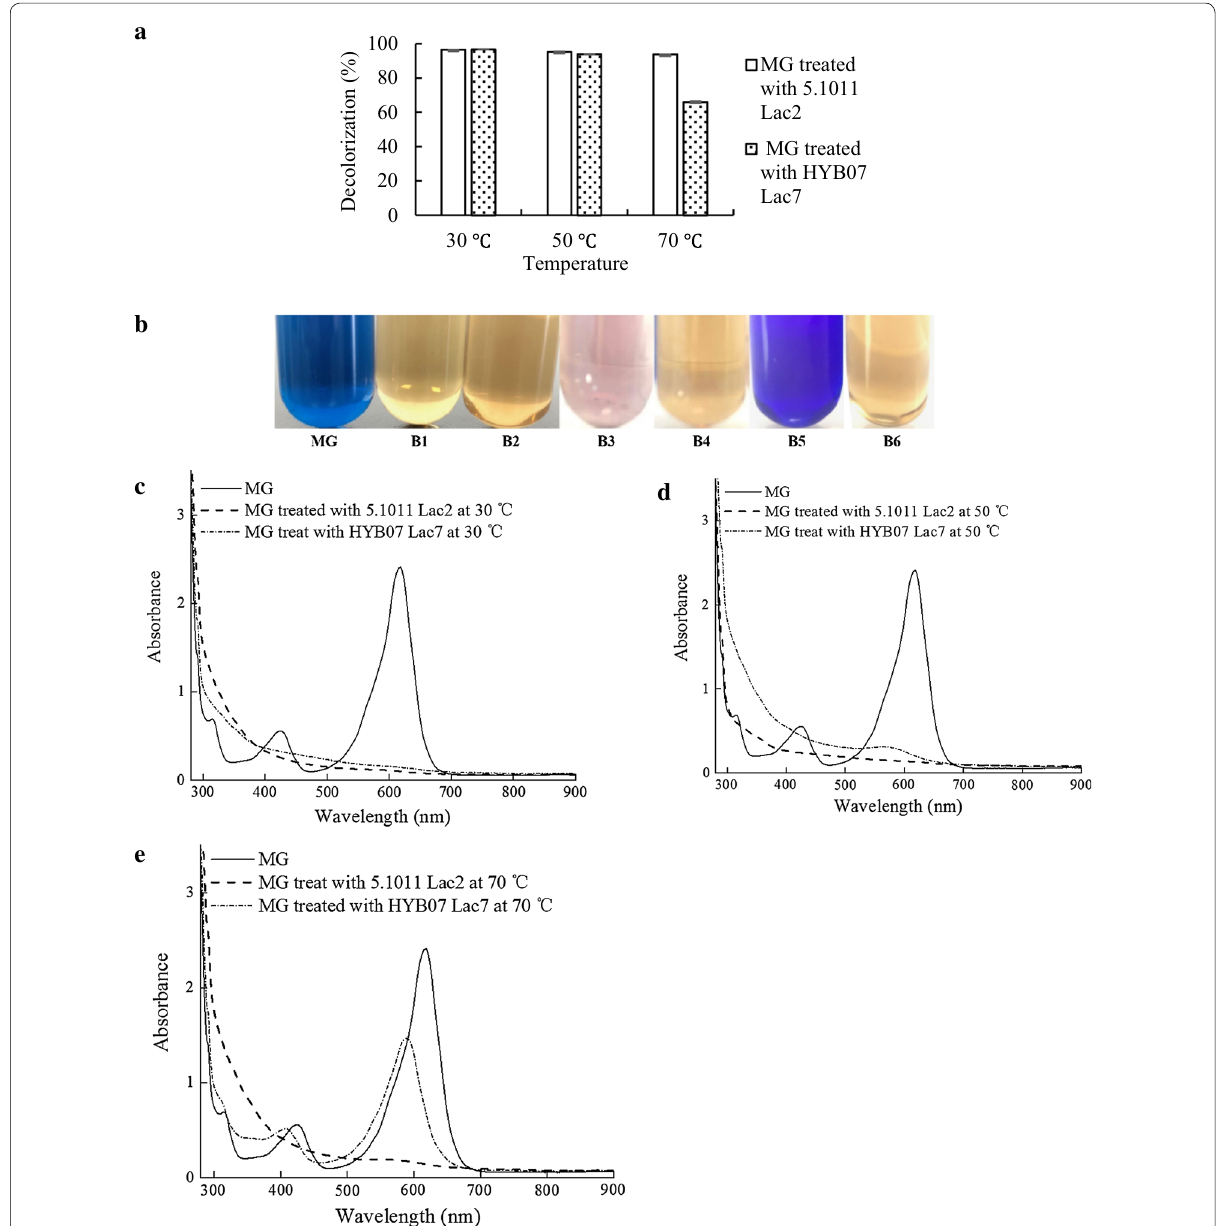
Fig. 6 Laccase-mediated decolorization of MG. a Decolorization efficiency of MG by laccases at 30, 50 and 70 °C. b MG after laccases-mediated decolorization at different temperatures. B1, B3, B5: MG treated with HYB07 Lac7 at 30, 50 and 70 °C, respectively. B2, B4, B6: MG treated